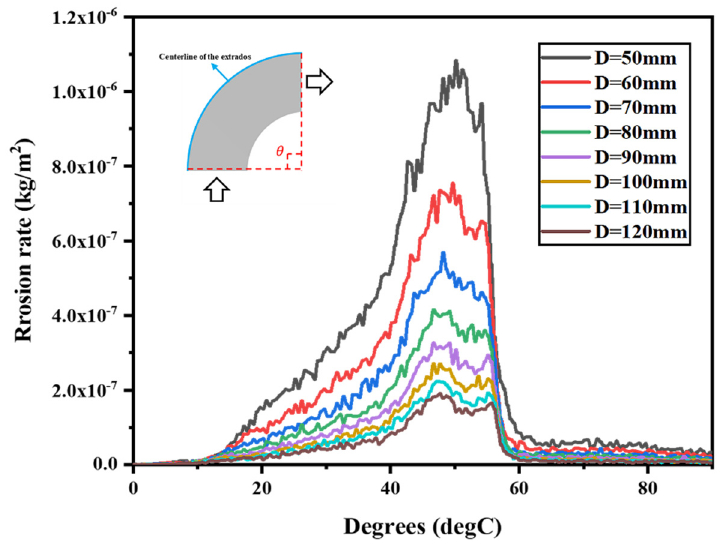
Figure 24. Erosion data of the center line of the elbow external arch with different pipe diameters.